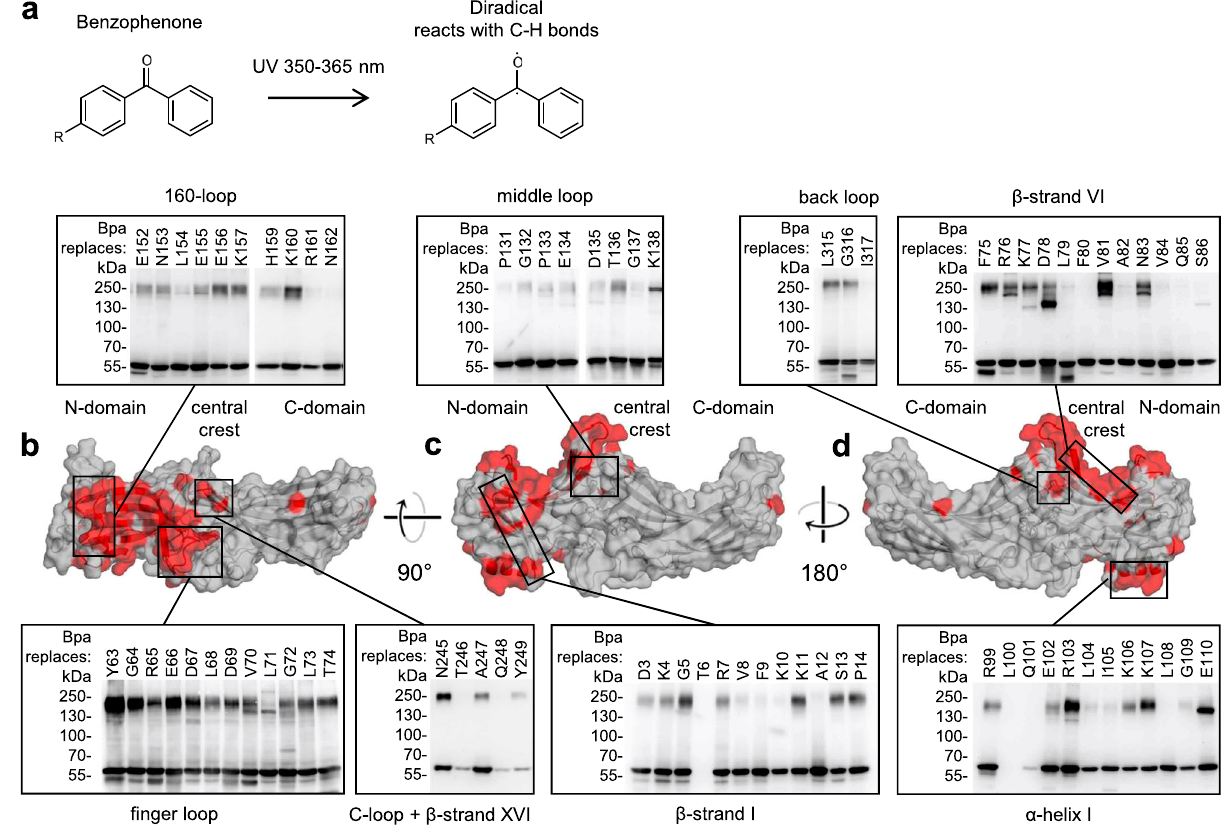
Fig. 1 | Footprint of PTH1R on arr2. a Photo-activation of Bpa by UV light. The diradical species inserts into C-H bonds within an estimated radius of ∼ 3.1Å from the oxygen atom (i.e. up to ∼ 9 – 10Å from the C β ) 37 . b – d Surface representation of receptor-boundbovinearr2(PDBID:4jqi) 70 withcrosslinkinghitshighlightedinred; the insets are representative western blots of whole cell lysates from photo- crosslinking experiments ( n =1) detected with an α -HA antibody (comprehensive